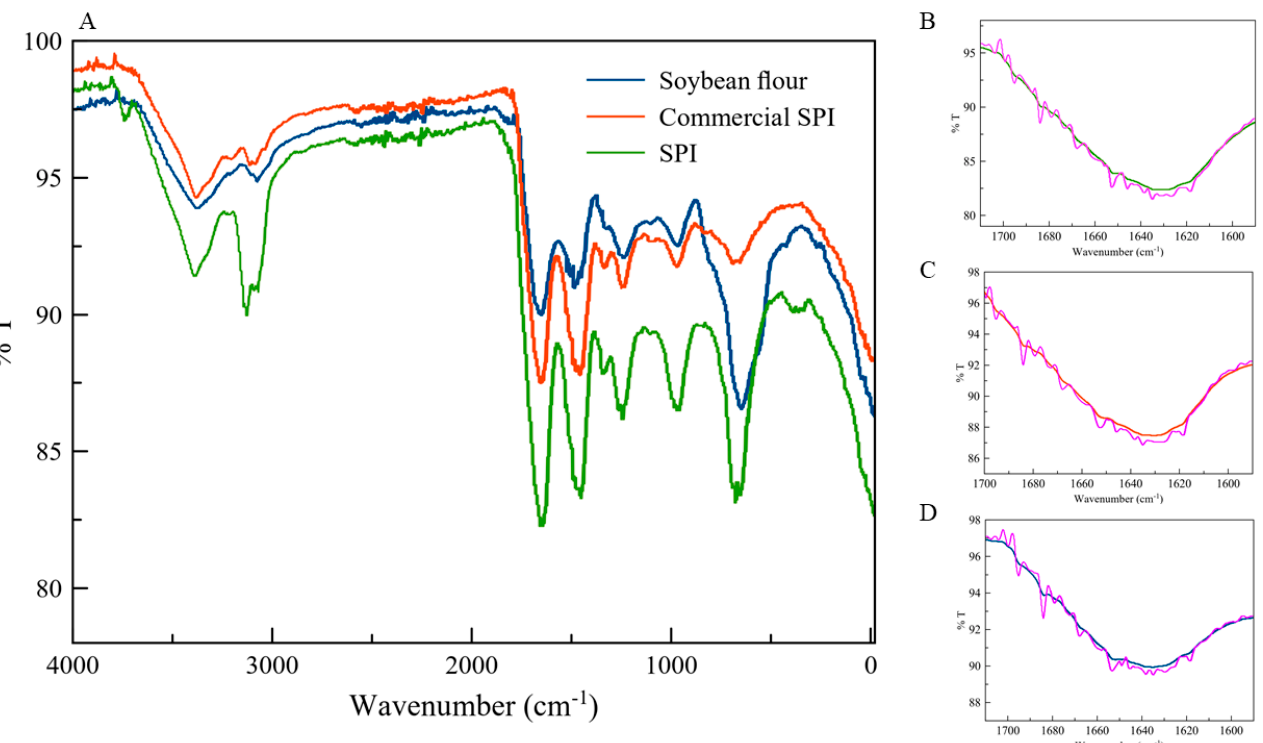
Figure 5. FTIR spectra of soybean flour, commercial SPI, and obtained SPI ( A ); deconvolution of obtained SPI ( B ), deconvolution of commercial SPI ( C ), and deconvolution of soybean flour sample ( D ).